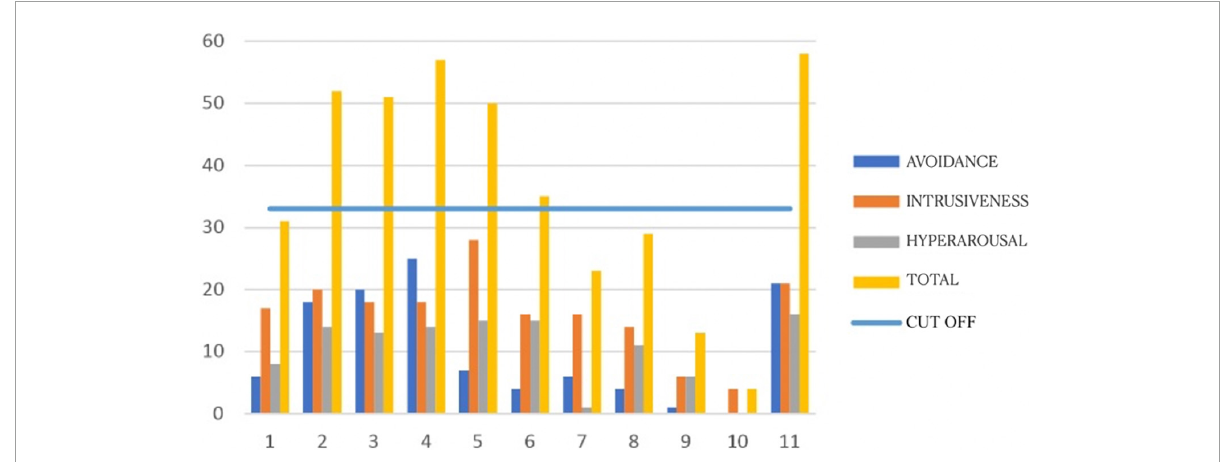
FIGURE1 Impact of Event Scale-Revised (IES-R) pre-intervention scores for each